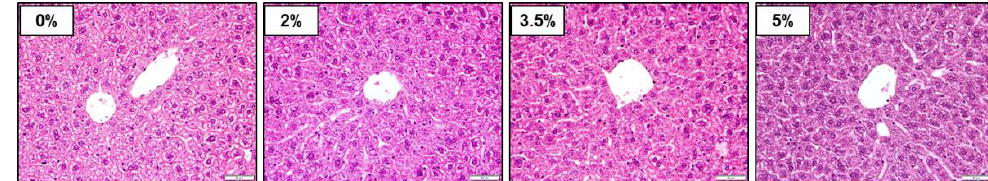
Figure 3. Changes in liver injury parameters. ( A ) Liver-to-body weight ( B ) and ( C ) serum activities of alanine aminotransferase (ALT) and aspartate aminotransferase (AST) in the DSS-treated mice.